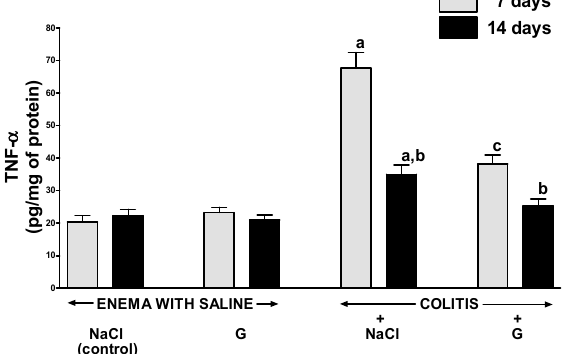
Figure 6. Effect of intraperitoneal administration of saline (NaCl) or ghrelin (G) on concentration of TNF- α in colonic mucosa after seven or 14 days from enema with saline or colitis induction. Mean value ± SEM. n = 8 animals in each group. a p < 0.05 compared to control at the same time of observation; b p < 0.05 compared to a value observed at the same group after seven days from colitis induction; c p < 0.05 compared to rats with colitis treated with NaCl at the same time of observation.